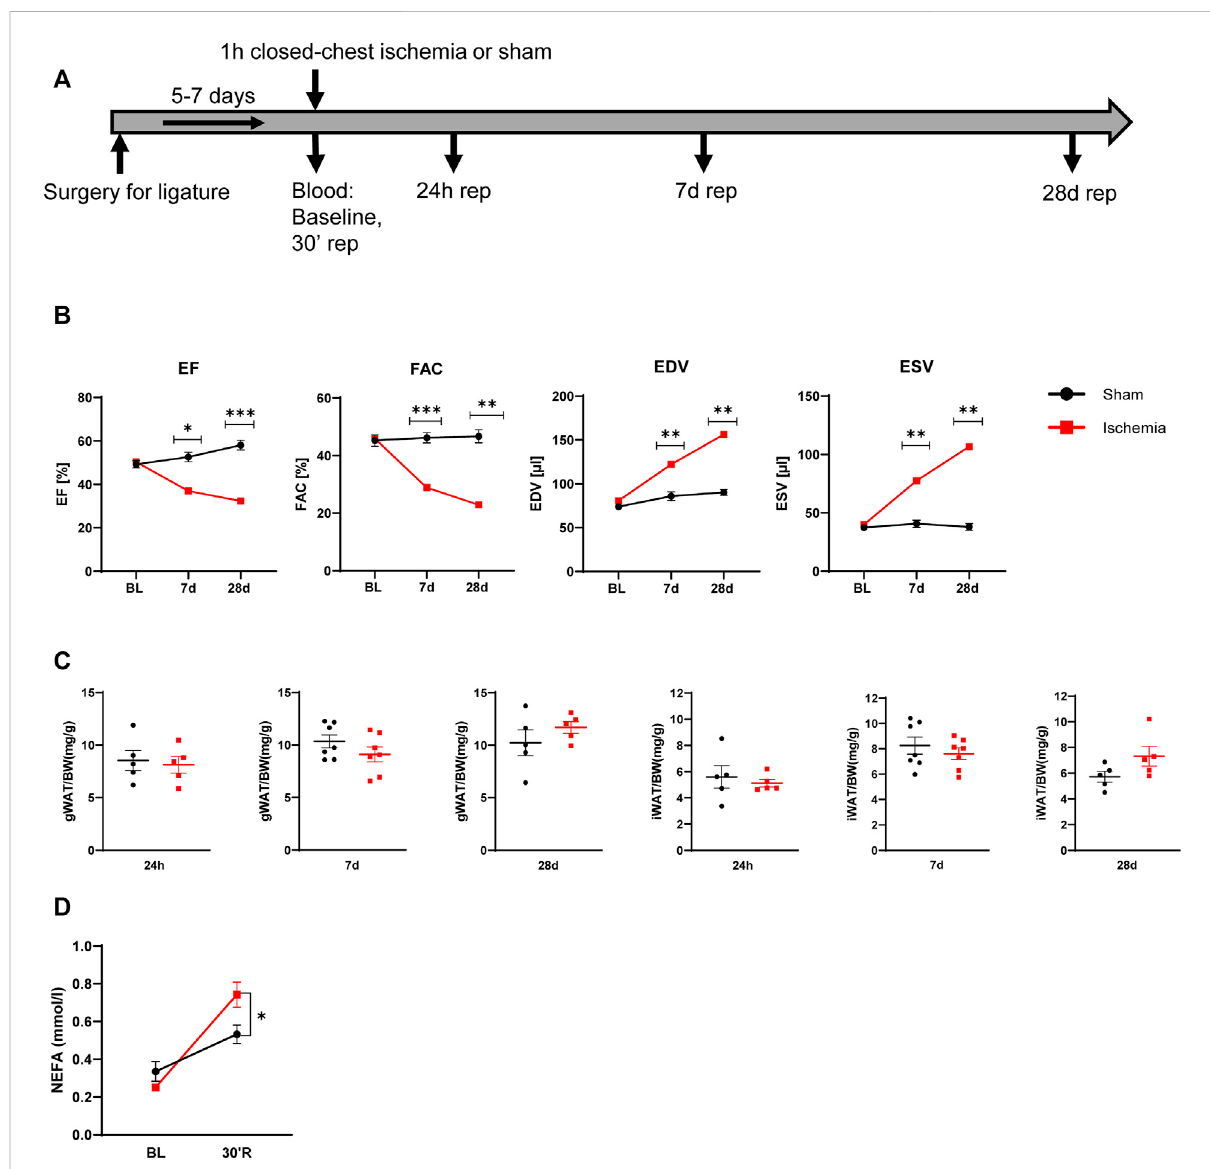
FIGURE 1 Model of myocardial infarction (A) Schematic of used mouse model of myocardial infarction (B) Cardiac function and volumes at baseline and after 7 and 28 days reperfusion ( n = 5) EF: ejection fraction, FAC: fractional area change, EDV: end diastolic volume, ESV: end systolic volume